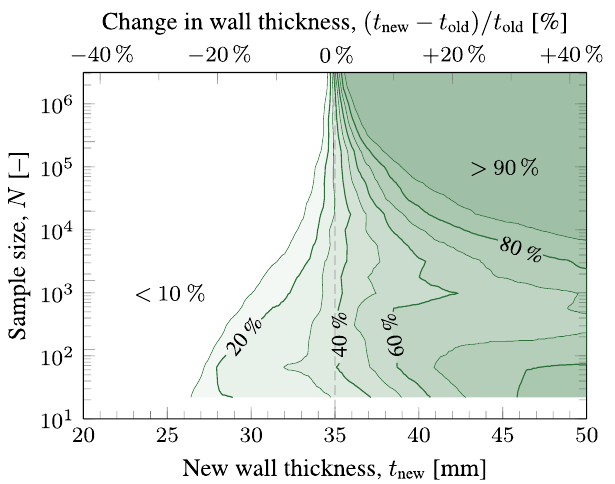
Figure 11. Relative number of times a new wall thickness is accepted on the basis of a 50-year stress level, predicted with an aggregation-before-fitting approach with a GEV fitted above a